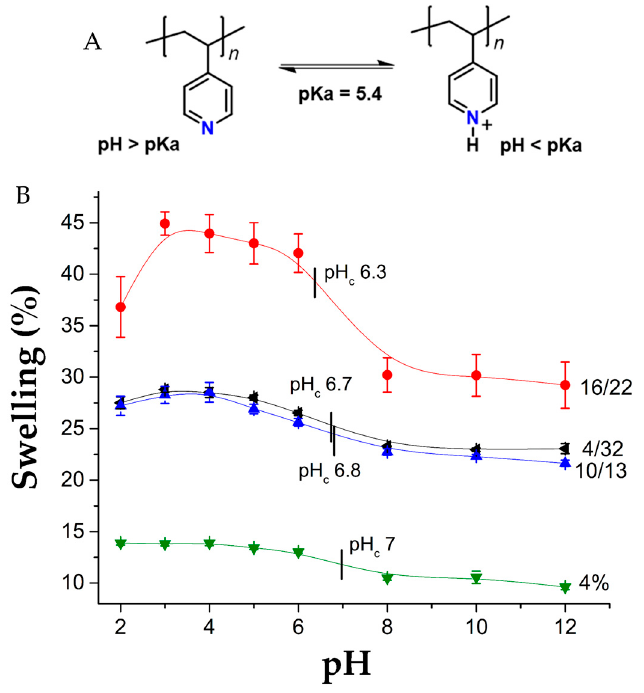
Figure 6. ( A ) Acid-base balance of 4VP and ( B ) pH-sensitivity, reported: mean ± standard error of the mean, n =